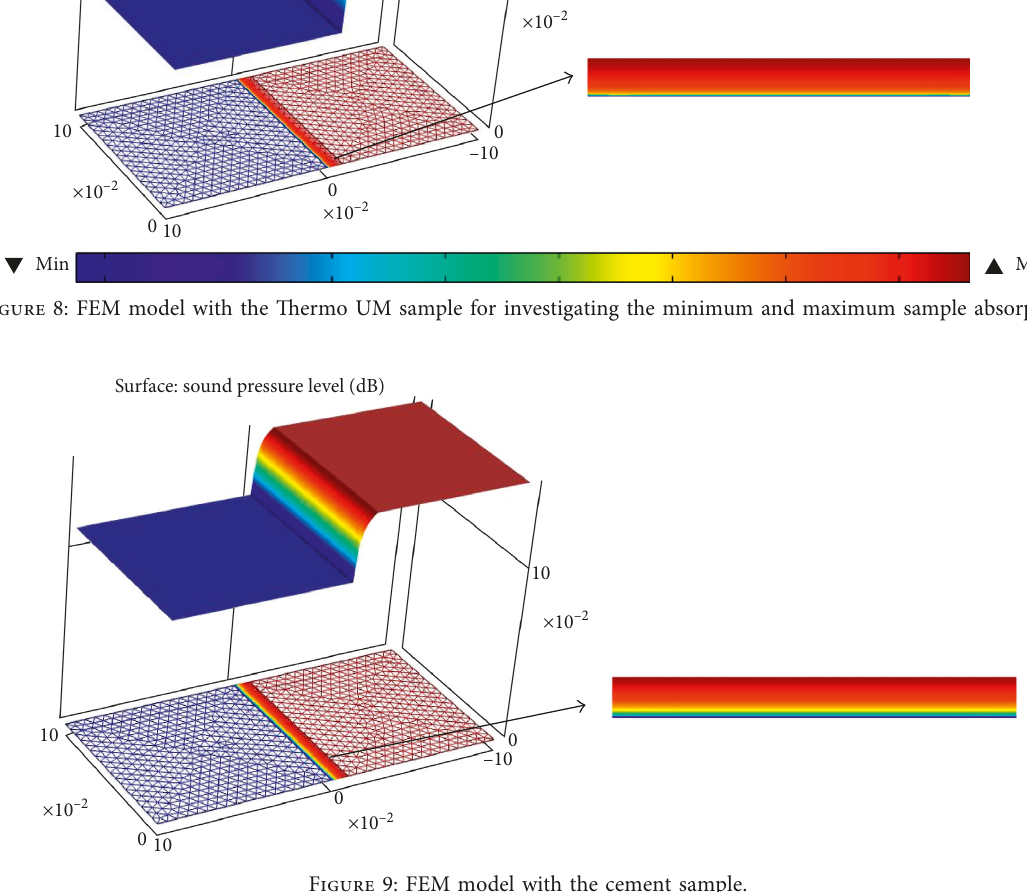
Figure 9: FEM model with the cement